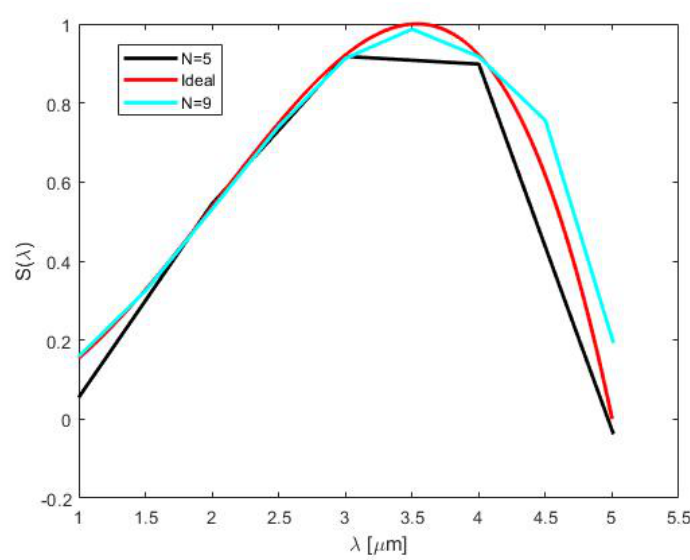
Figure 6. Spectral response function reconstruction with “Sinc”